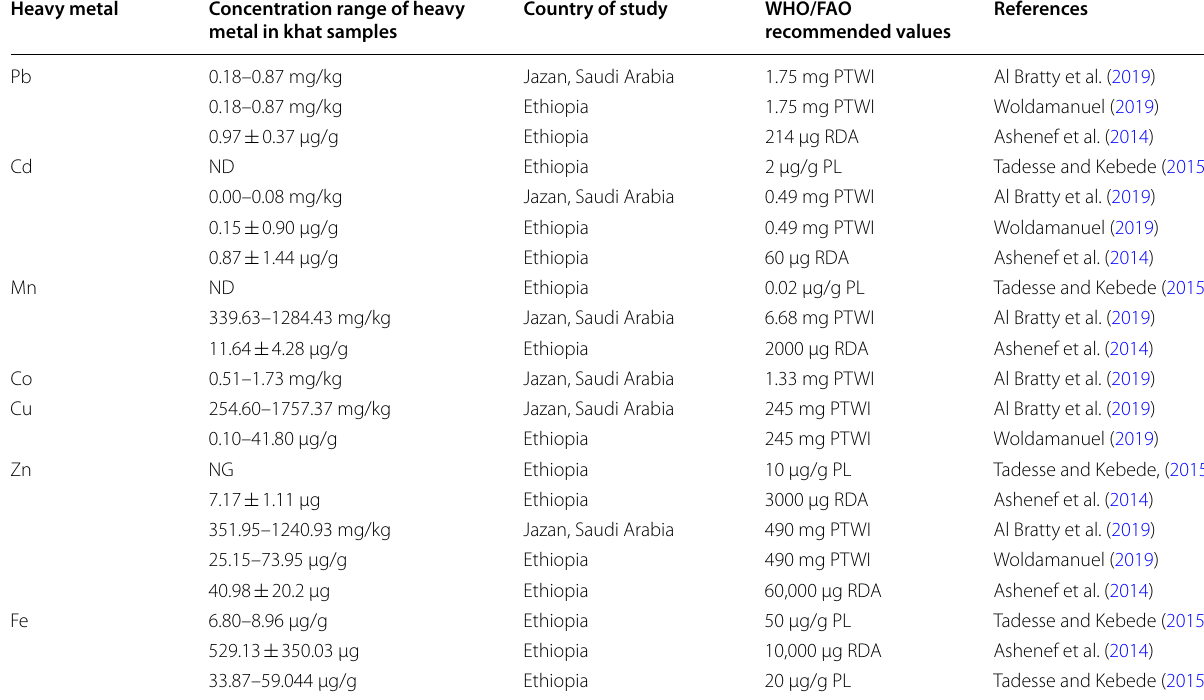
metal permissible